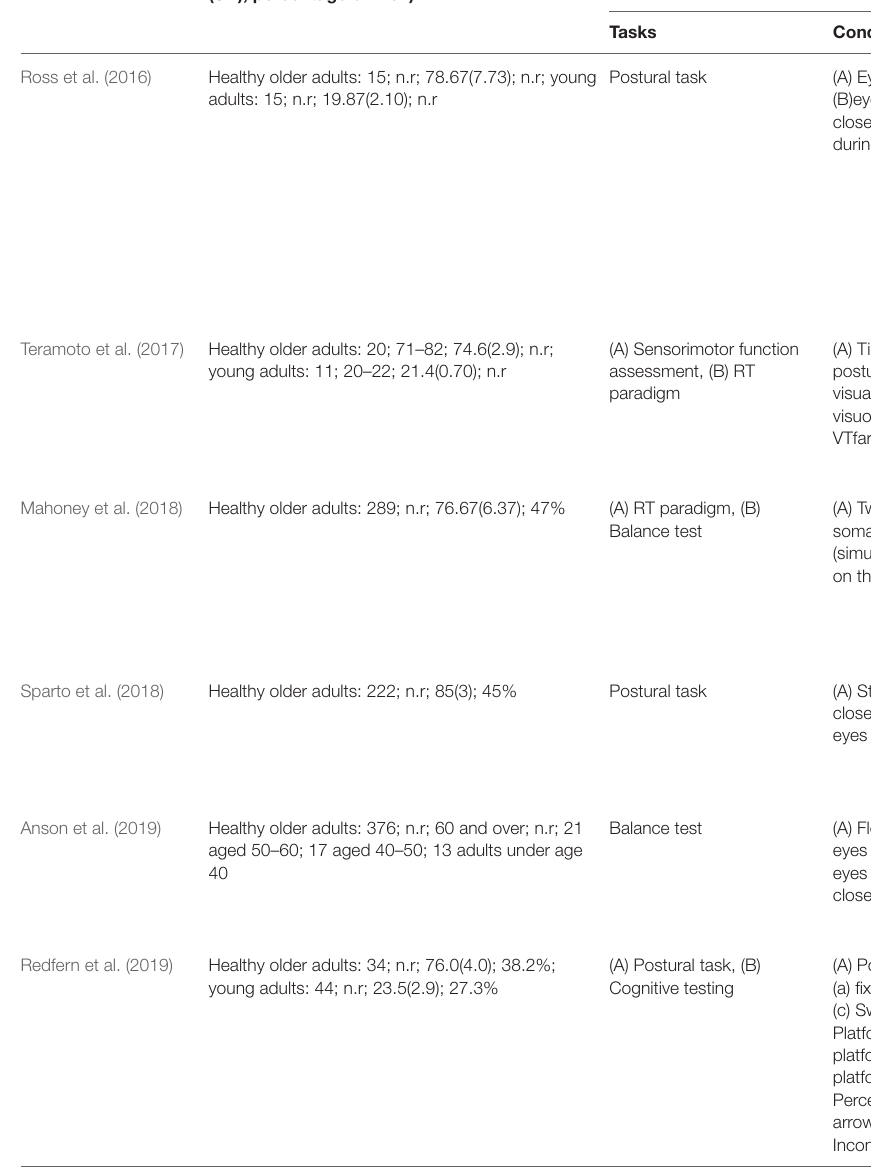
across condition and using two-way analyses of variance (eyes closed vs. open